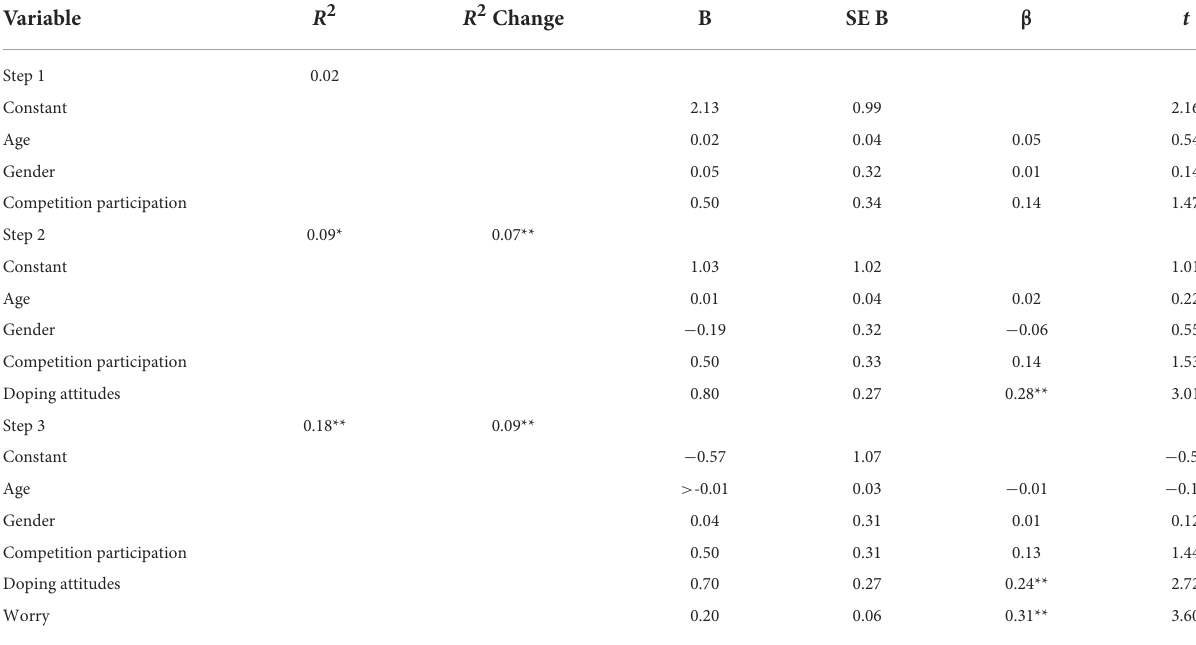
TABLE 3 Hierarchical regression model of analgesic misuse in a favorable